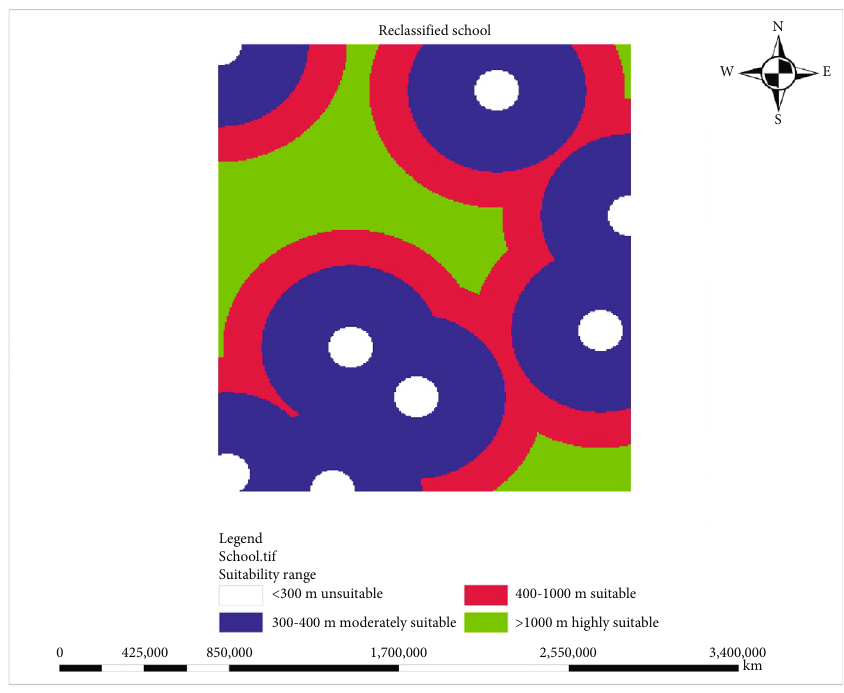
Figure 7: Suitable school distance for solar PV.